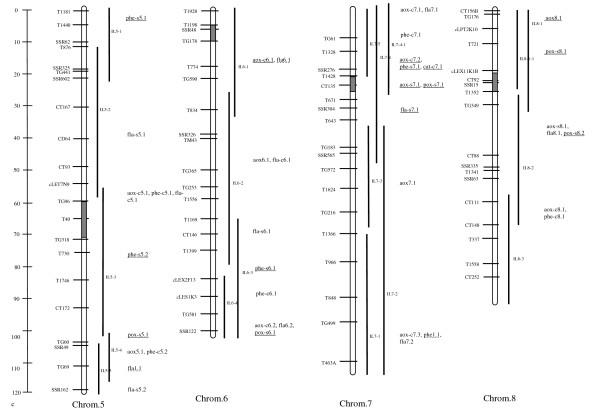
Linkage map for chromosomes 5 to 8 of the IL population showing the locations of QTL identified in this work. For loci that are underlined, S. pennellii alleles were associated with increased content/activity. Wild alleles for non-underlined loci were associated with decreased content/activity. Dotted underline indicates that the wild alleles were associated with both increased and decreased content/activity, depending on the environment (control or salt).